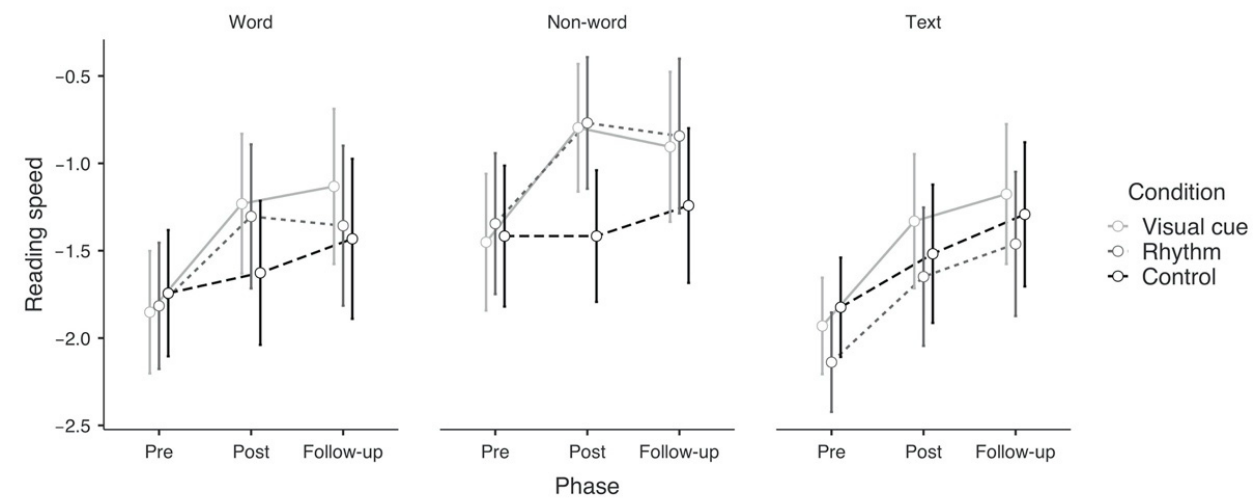
Figure 1. Reading speed z-scores under the three conditions (i.e., Visual cue, Rhythm, No intervention) at each timepoint (i.e., Pre, Post, Follow-up).